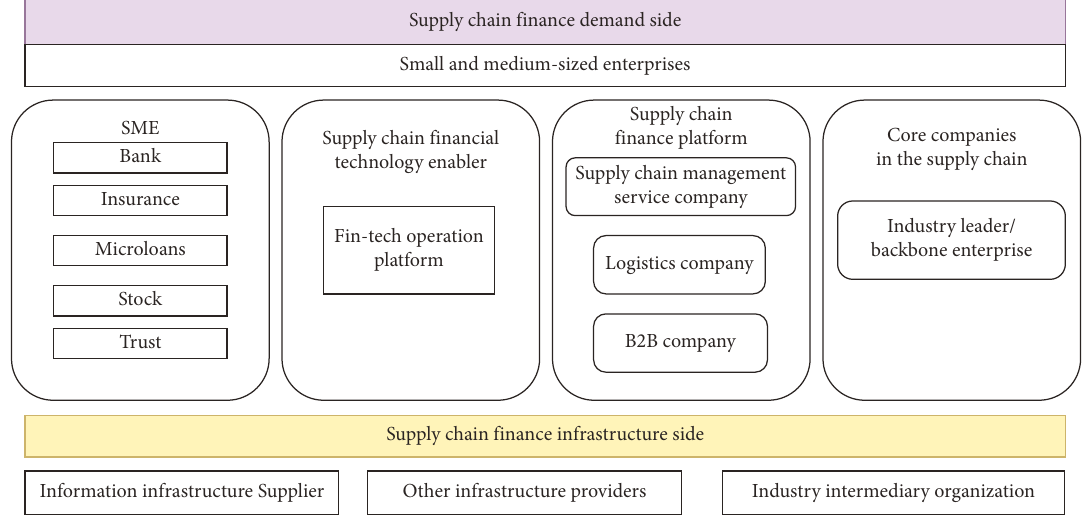
Figure 2: Supply chain finance participants organization model.